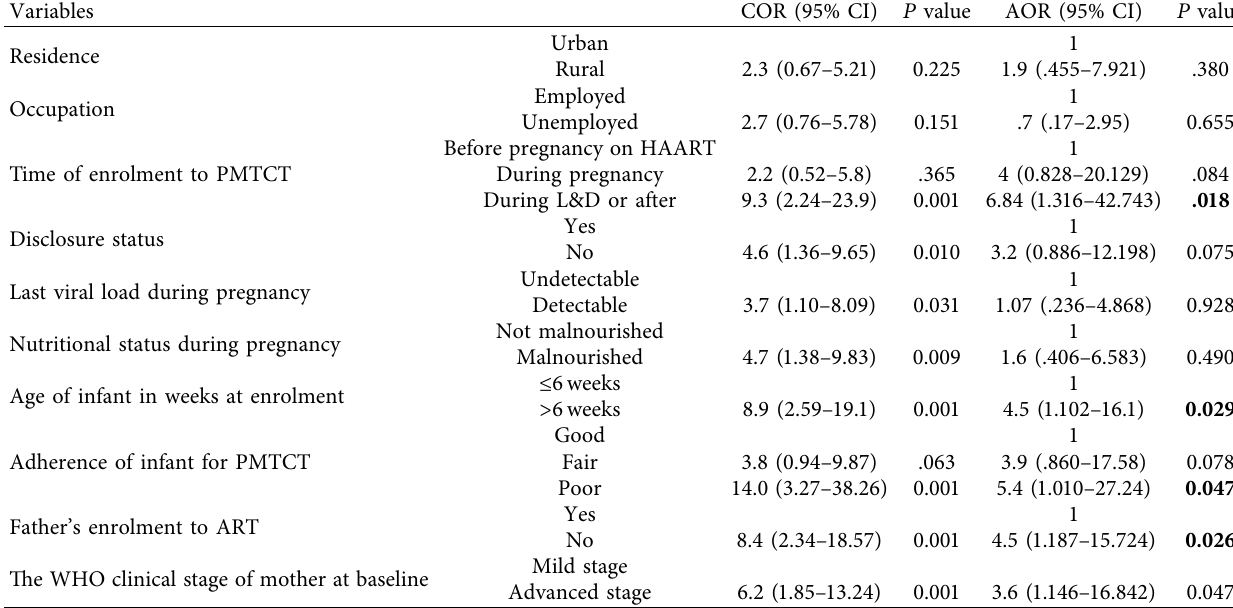
Table 4: Multivariate analysis of predictors of MTCT of HIV in public general hospitals of West Guji Zone, Oromia, Ethiopia, 2020 ( n �